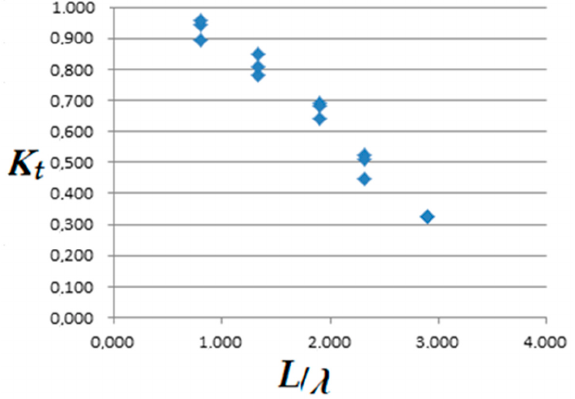
Figure 10. The relationship between wave steepness and reflection coefficient at different water depths.